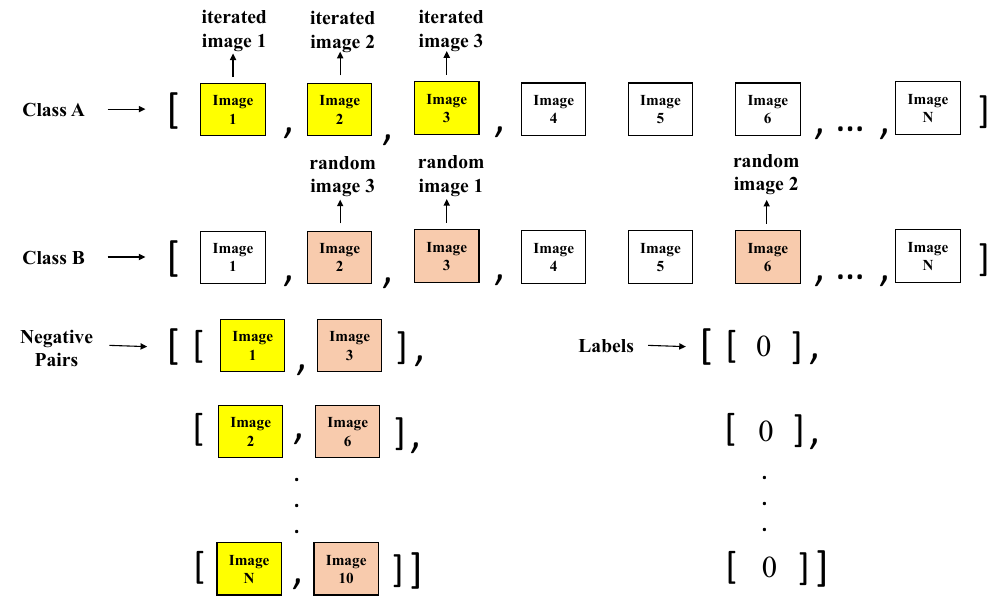
Figure 11. Negative pairs’ creation